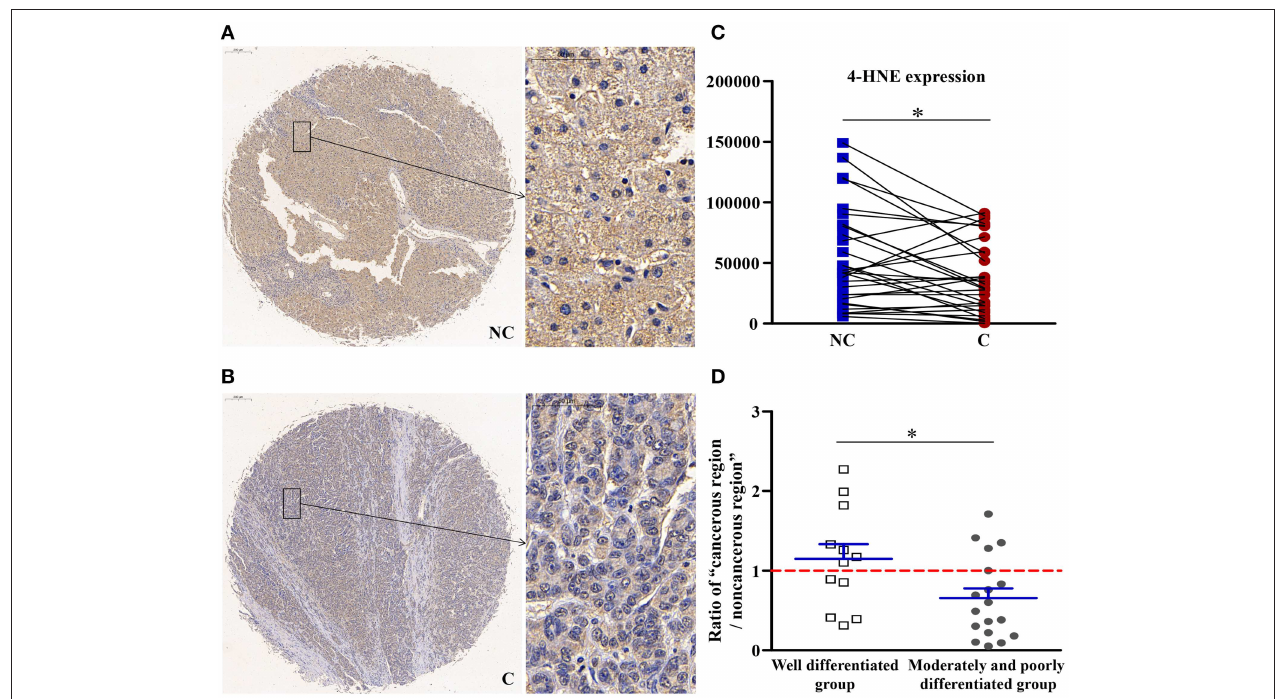
FIGURE 1 | The detailed expression of 4-HNE. Representative images of 4-HNE protein expression in liver cancer’s corresponding (A) non-cancerous (NC) and (B) cancerous (C) regions. (C) Quantification of 4-HNE expression level using multispectral image analysis in the liver cancer samples. (D) The ratio of “cancerous region/non-cancerous region” of 4-HNE expression in two groups (well-differentiated group vs. moderately and poorly differentiated group). The red line indicates that the ratio is equal to 1. Scale bar: 200 or 50 µ m. *Denotes significant differences from the noncancerous region, or well-differentiated group with P <